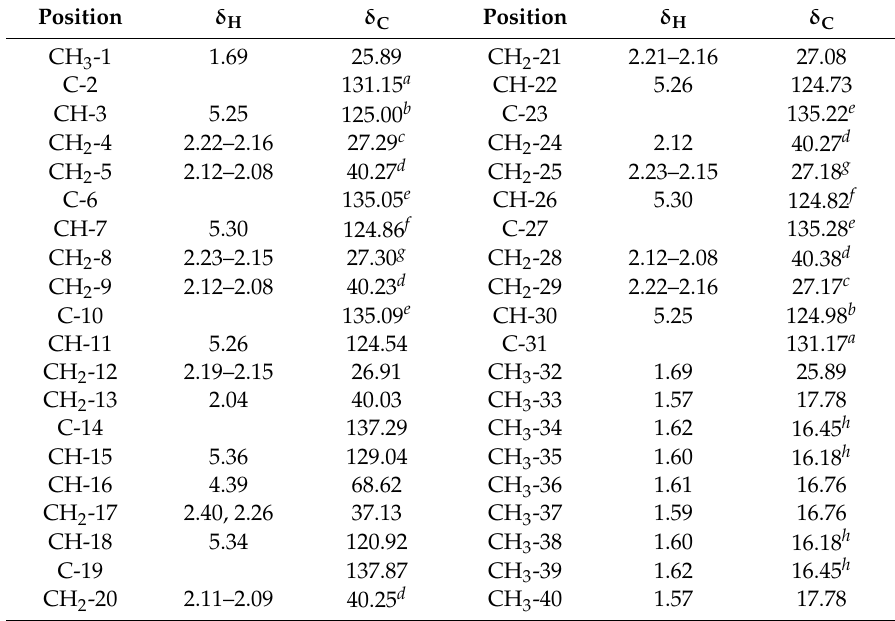
Table 1. 1 H (500 MHz) and 13 C * (125 MHz) NMR data for Compound 1 in C 6 D 6 .